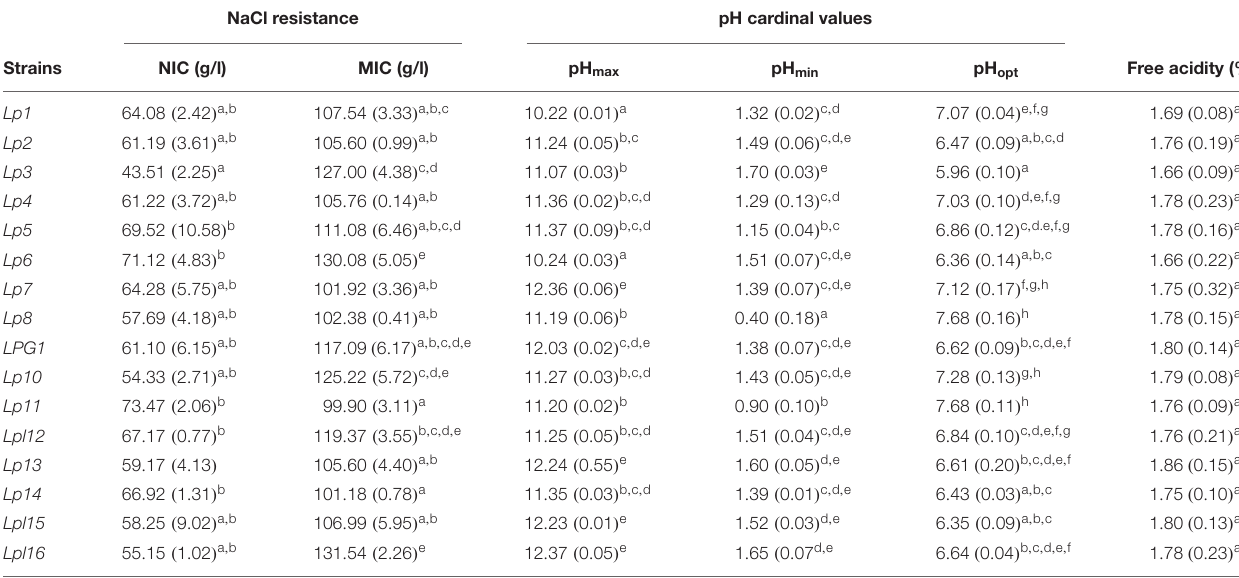
Values are expressed as mean and standard deviation (in parentheses) obtained from triplicate experiments. Different superscript letters, within the same column, means significant statistical difference (p ≤ 0.05) according to the Scheffé post hoc comparison test. NIC and MIC values for NaCl, cardinal parameters for pH, and production of titratable